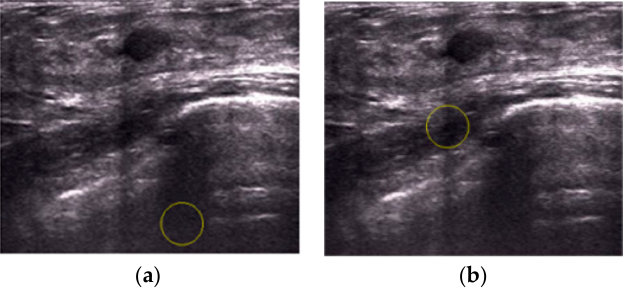
Figure 18. Wrong localization results of Liu’s method and the proposed method. ( a ) Localization results of Liu’s method and ( b ) the results of the proposed method.